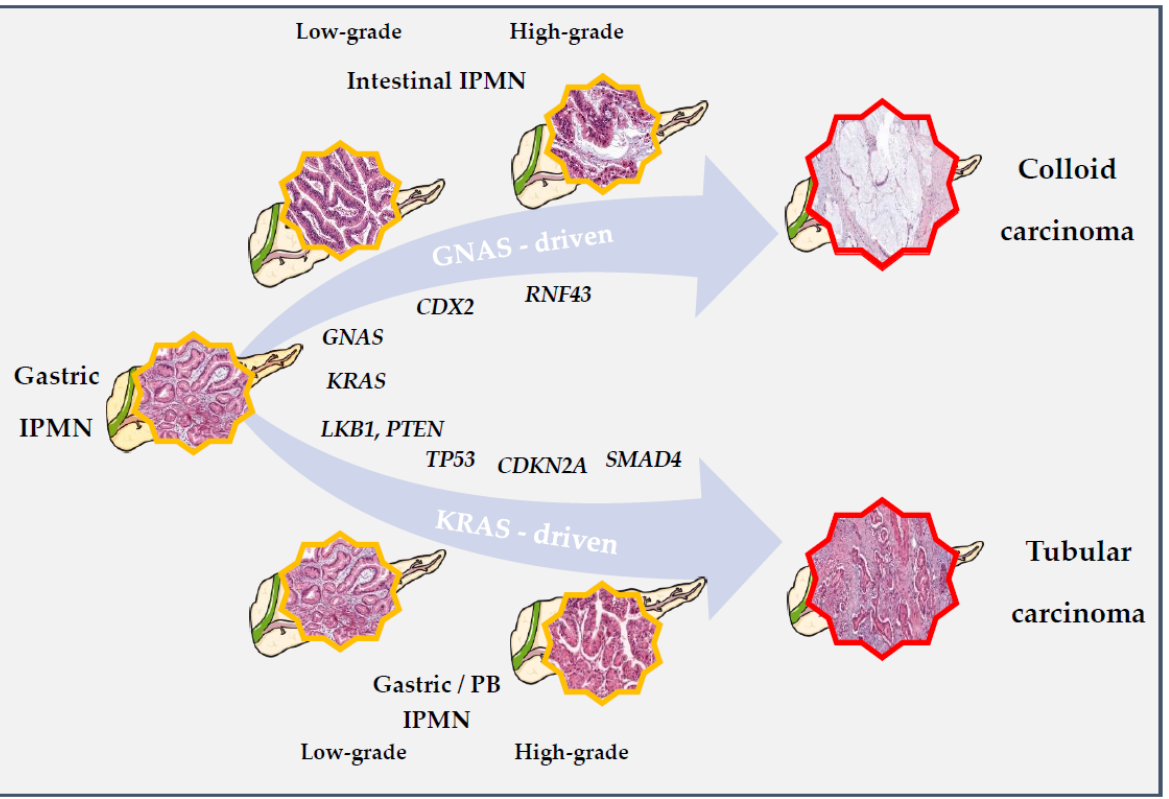
Figure 4. Hypothetic pathways for IPMN initiation and progression to IPMC. In available murine models, KRAS appears critical to IPMN’s initiation in both the intestinal and gastric-PB pathways. The early association of KRAS and GNAS is supposed to correlate with the differentiation toward the intestinal subtype, associated to CDX2 expression and RNF43 alterations. In these lesions, GNAS signaling is supposed to drive carcinogenesis and induce a unique molecular program (in which KRAS mutations may be later selected against), leading to the occurrence of colloid type carcinomas with less aggressive features. Contrarily, other mutations such as PTEN or LKB1 (among others) might, in association with KRAS , induce the differentiation toward the non-intestinal pathway relying on a classical KRAS -driven carcinogenesis. Like cPDAC, common mutations such as TP53 , CDKN2A , or SMAD4 accumulate during progression of these lesions, resulting in a tubular IPMC almost identical to cPDAC. GNAS mutations may occur also in this subset but at later stages, without taking over KRAS induced